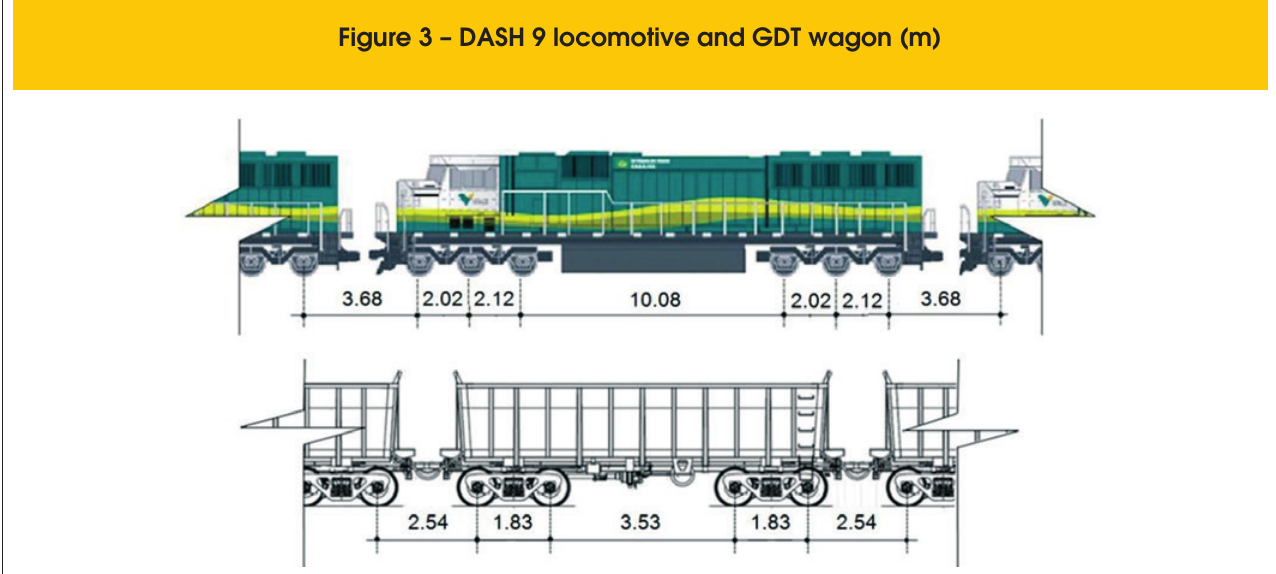
Figure 3 – DASH 9 locomotive and GDT wagon